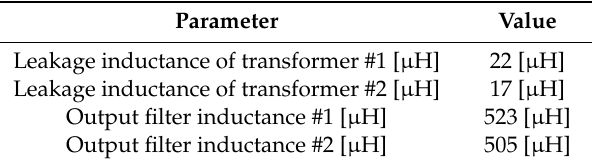
Table 2. Mismatched parameters of ISOP converter.